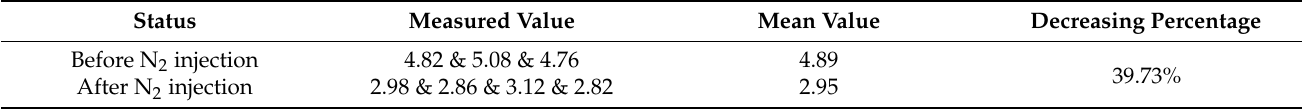
Figure 12. The schematic diagram of sampling boreholes design. Table 3. The test results of coal seam gas content (m 3 /t).